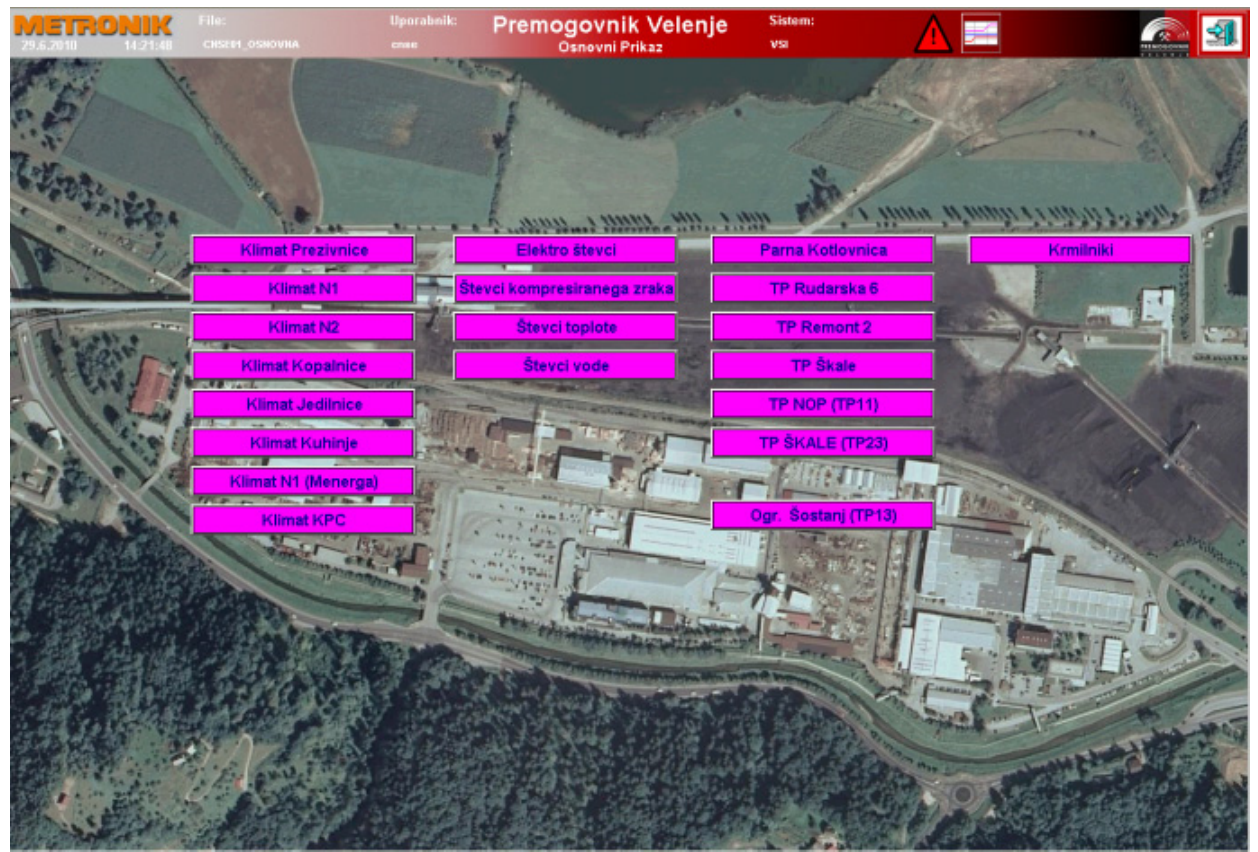
Figure 2. Basic graphical SCADA interface of Velenje Coal Mine’s CSRE